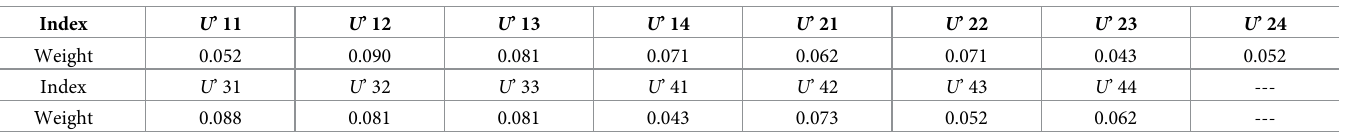
Table 4. Weights of the evaluation